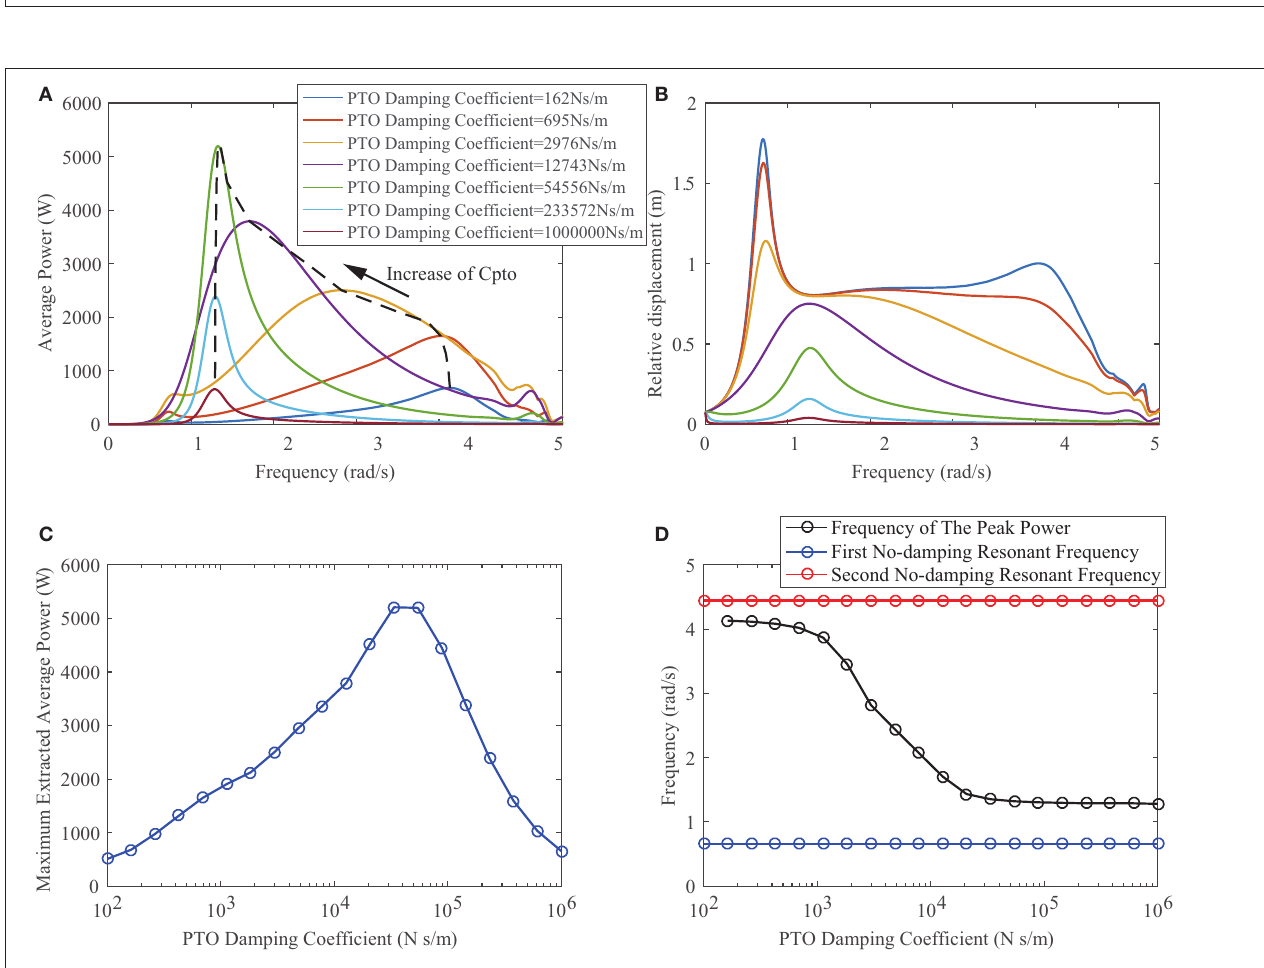
FIGURE 8 | Extracted average power (A) and relative displacement (B) vs. wave frequency at various PTO damping coefficients. Maximum extracted average power (C) and resonance frequencies (D) vs. PTO damping coefficient.